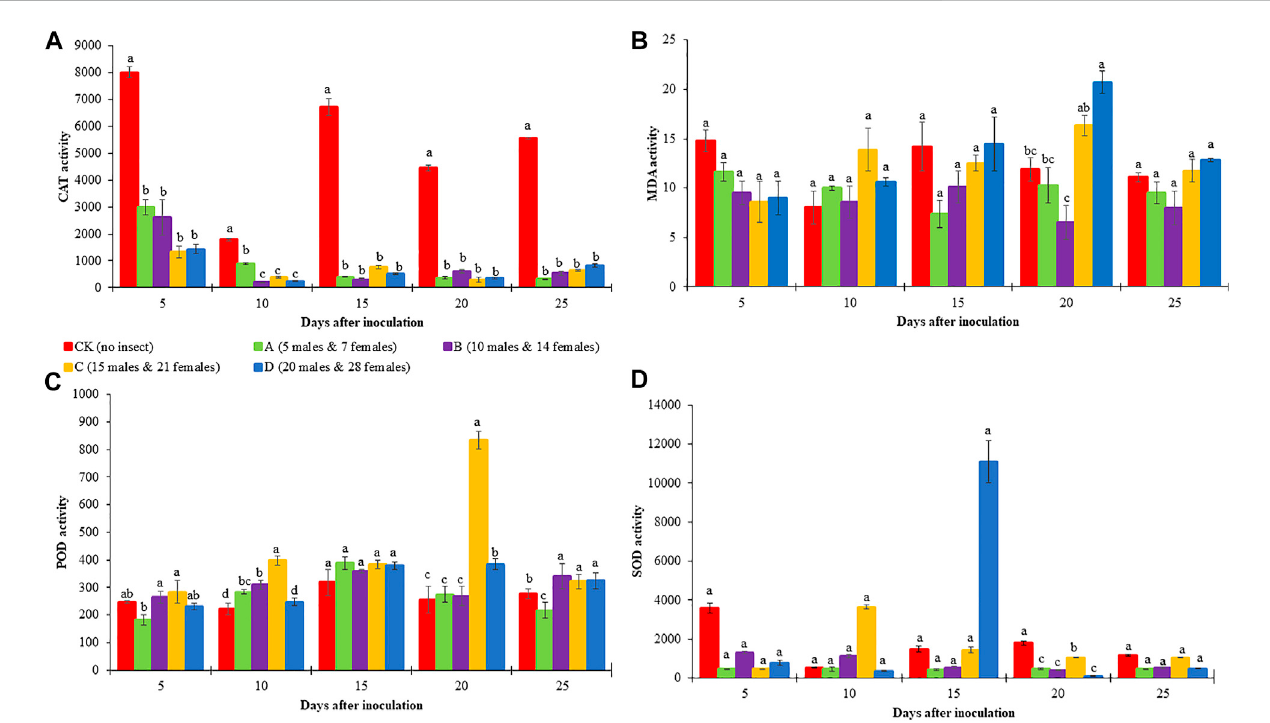
FIGURE 2 Enzyme activity in the leaf of Cocos nucifera infested with different densities of red palm weevil (RPW). (A) Catalase (CAT), (B) Malondialdehyde (MDA), (C) ,Peroxidase(POD),and (D) Superoxidedismutase(SOD). Eachresult represents theaverage ofthreereplicates. The errorbarsrepresent thestandard error of the mean (SEM). Bars in each sampling time with the different alphabets indicate signi fi cant differences ( p >